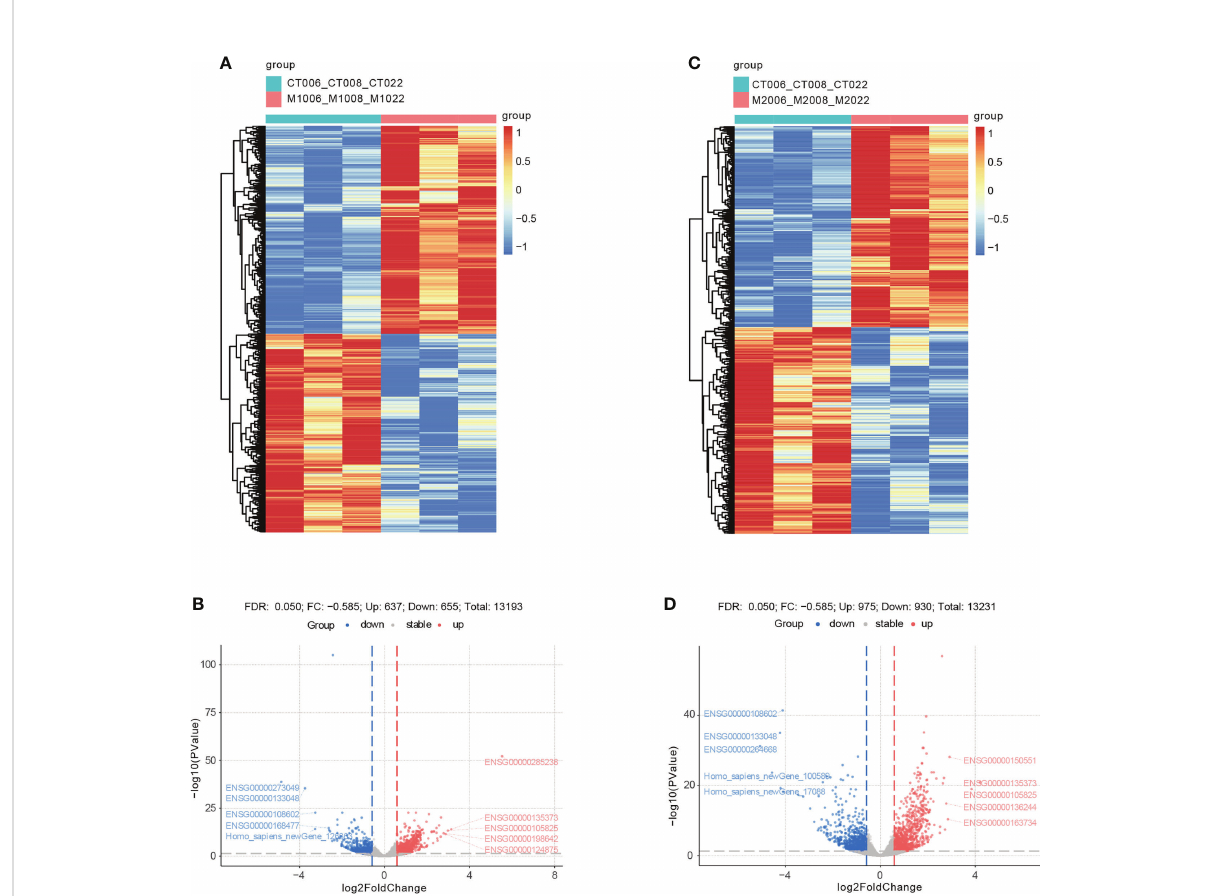
FIGURE 6 Cluster analysis and volcano plot showing differentially expressed genes (DEGs) in M1CM or M2CM treated NPCs. (A, B) Cluster analysis heat map of DEGs, where each small square represents each mRNA, and its color represents the amount of mRNA expression. The greater the amount of mRNA expression, the darker is the color (red indicates high expression, blue indicates low expression). The fi rst line indicates sample grouping, blue indicates treatment samples, red indicates control samples. Each row represents the expression of each mRNA in different samples, and each column represents the expression of all differential mRNAs in each sample. The tree on the left shows the cluster analysis results of different mRNAs from different samples. (C, D) Volcano map of DEGs, where each dot represents an mRNA. A red dot indicates that the gene expression is upregulated, a blue dot indicates that the mRNA expression is down regulated, and a gray dot indicates that there is no signi fi cant difference in the mRNA